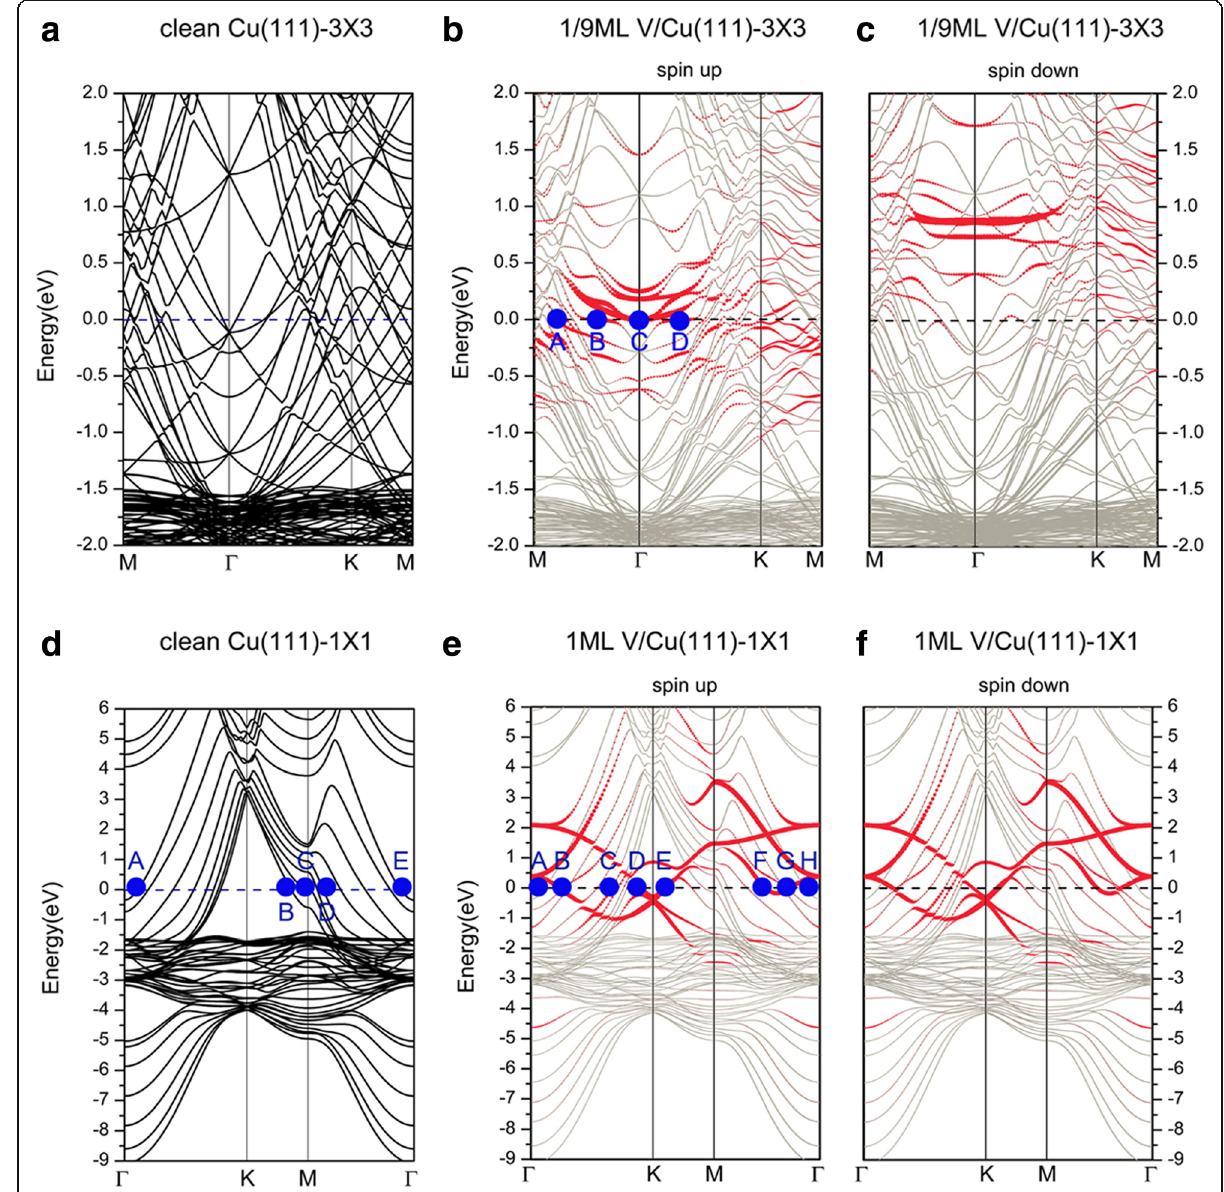
Fig. 3 Band structures of a clean Cu(111) surface, plotted in the Brillouin zones (BZ) of a 3 × 3 unit cell and d 1 × 1 unit cell. Band structures of V adsorption on Cu(111) surface with 1/9 ML coverage for b spin up and c spin down. Band structures of V adsorption on Cu(111) surface with 1 ML coverage for e spin up and f spin